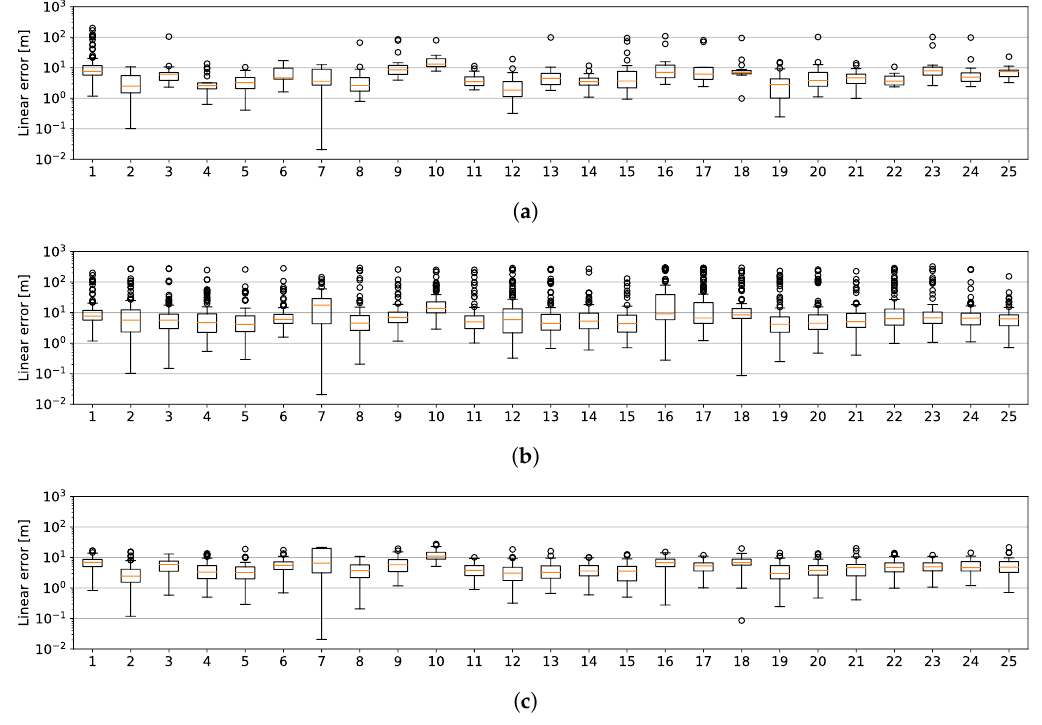
Figure 11. Statistics of the positional error as the localised trajectory is varied over the course of a month and the map is held constant. ( a ) represents kRadar@0.36 ( b ) kRadar@1 and ( c ) kRadar+SM . As described in Section 5.2, there is a bias in these errors (of approximately 10m) attributed to the manual alignment of the groundtruth odometry traces. Despite this, our proposed system is shown in Figure 11c to exhibit tighter variance over the course of this experiment. Please note the logarithmic scale.